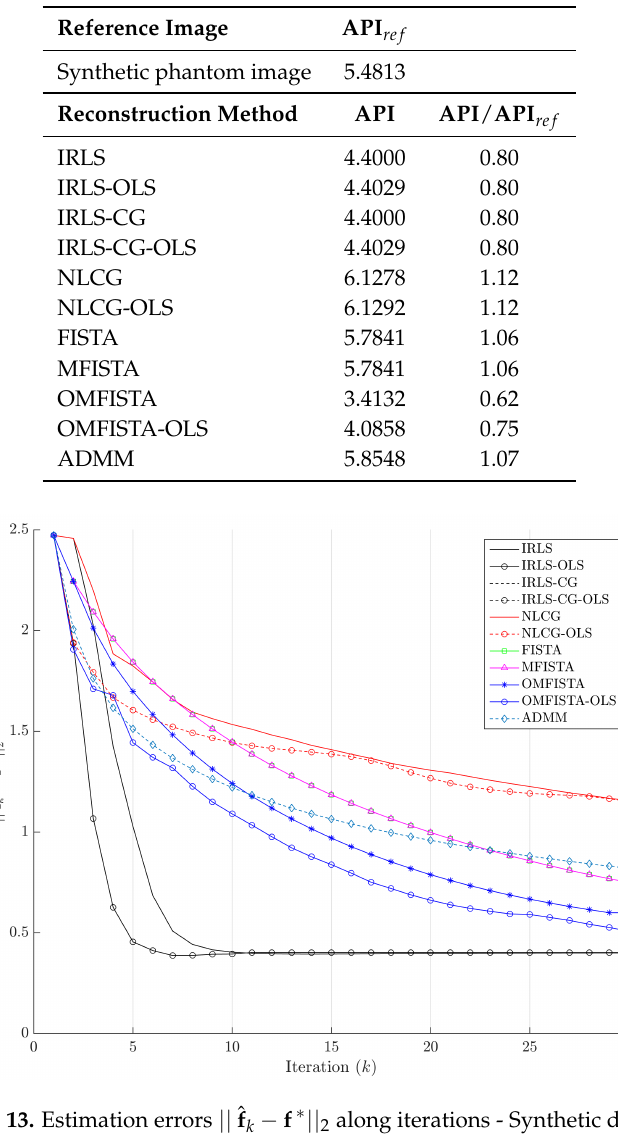
Table 2. API values for reconstructed images after 30 iterations—Synthetic dataset.